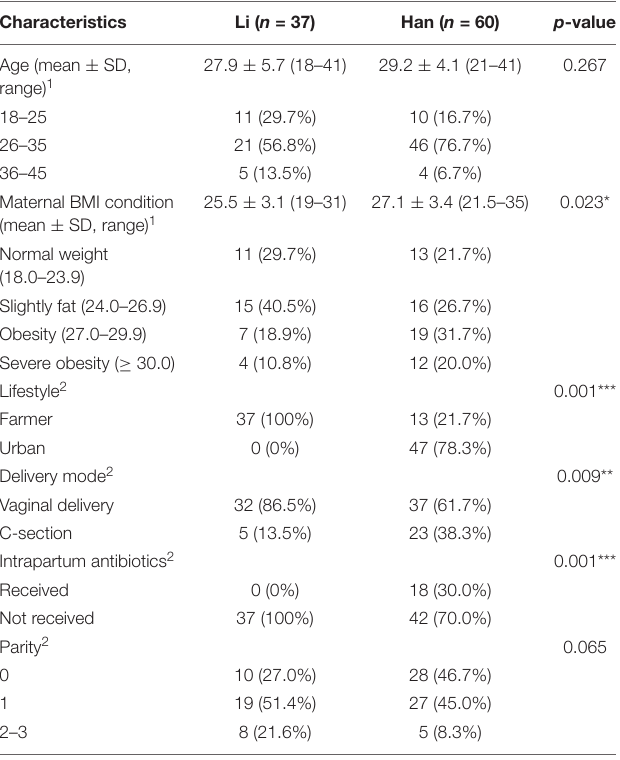
TABLE 2 | Socio-demographic characteristics of